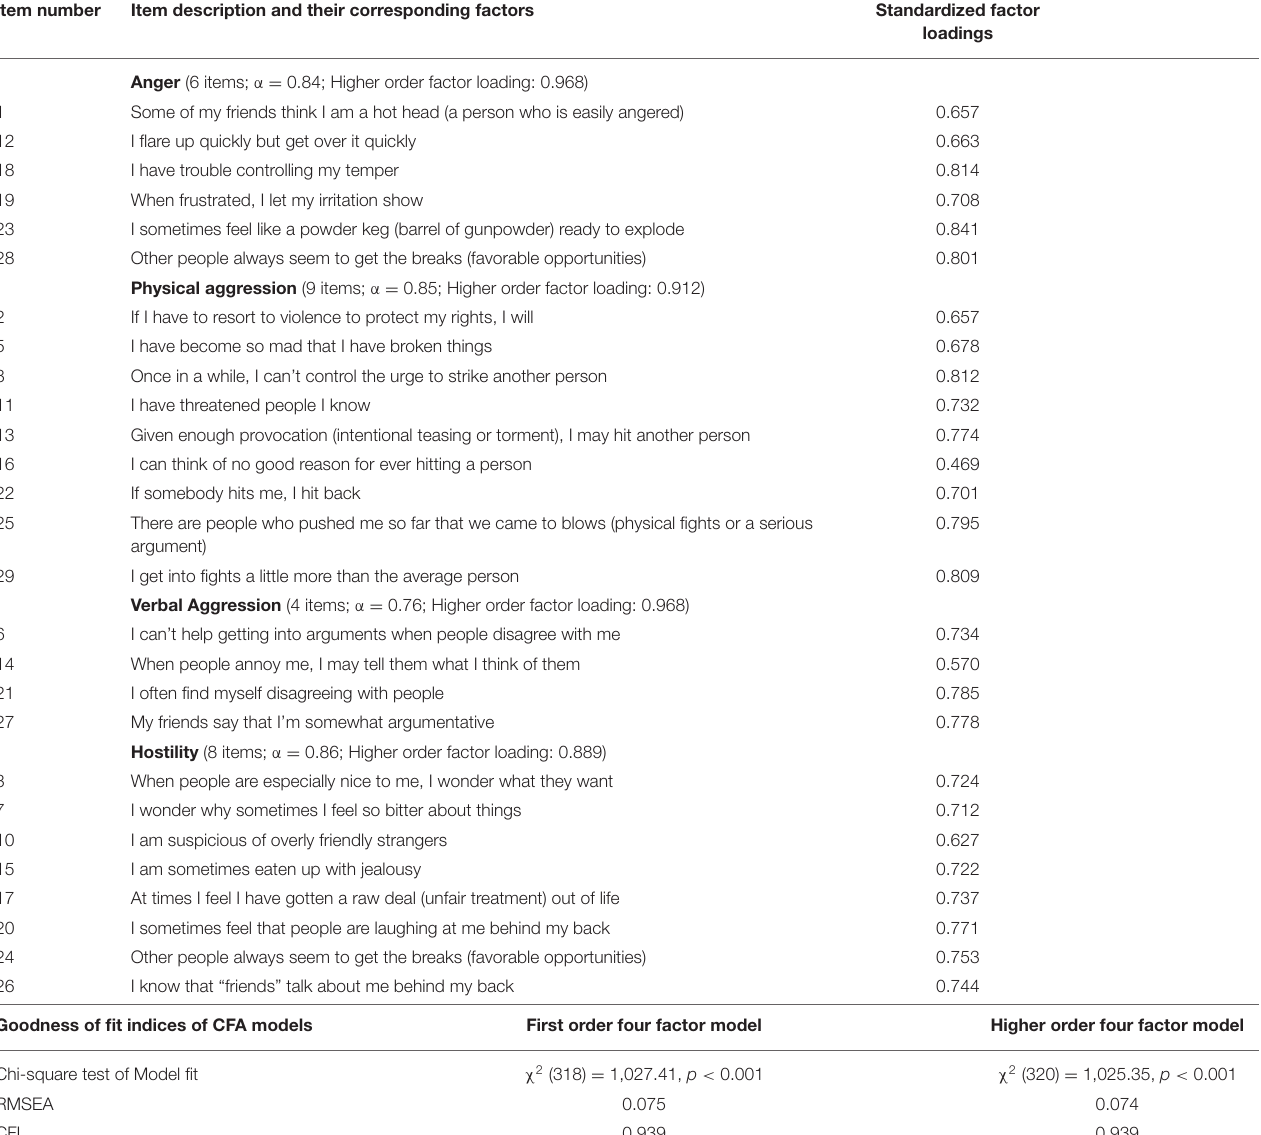
TABLE 2 | Standardized factor loadings and fit indices of the higher order four factor model. Item number Standardized factor